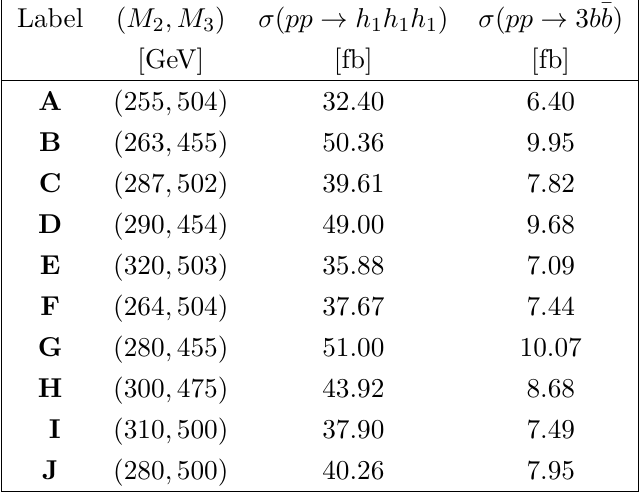
Table 2 . The leading-order gluon-fusion production cross sections for the pp → h 1 h 1 h 1 signal for different realisations of BP3 , depending on the masses of the scalars h and h in the region M 2 3 2 > 250 GeV and M 375 GeV. The given combinations of masses presented are allowed by current 3 > √ constraints. The numbers correspond to a proton-proton centre-of-mass energy of s = 14 TeV . The fourth column assumes mediation via the h intermediate state. The statistical integration 1 h 1 h 1 uncertainties are smaller than the accuracy shown